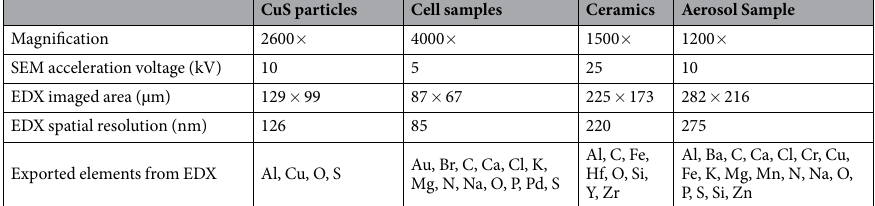
Table 2. Experimental parameters for SEM-EDX imaging of the different